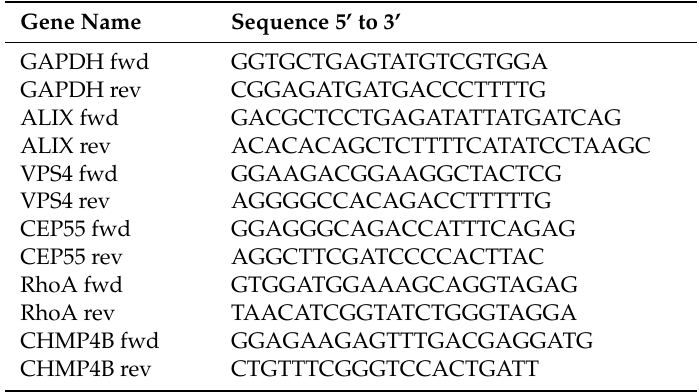
Table 2. Primer sequences